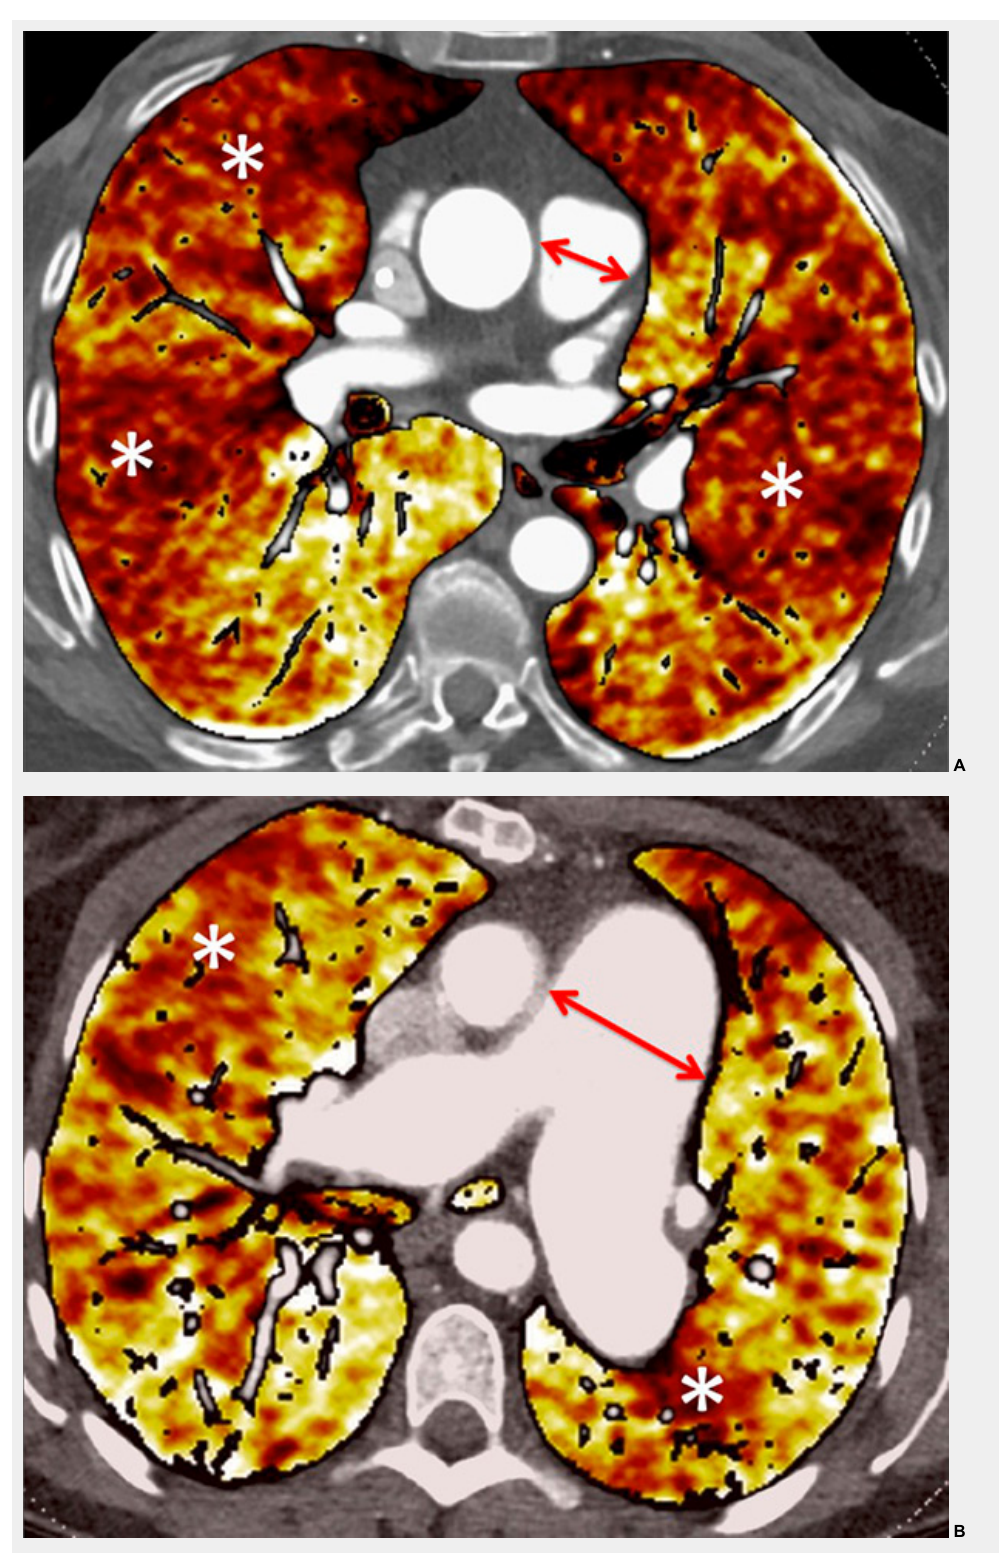
Figure 6 Perfusion heterogeneities in idiopathic pulmonary artery hypertension (stars) in two different patients ( A/B ). The dilatation of the arteries in pulmonary hypertension (arrows) is not always observed depending on the severity of pulmonary